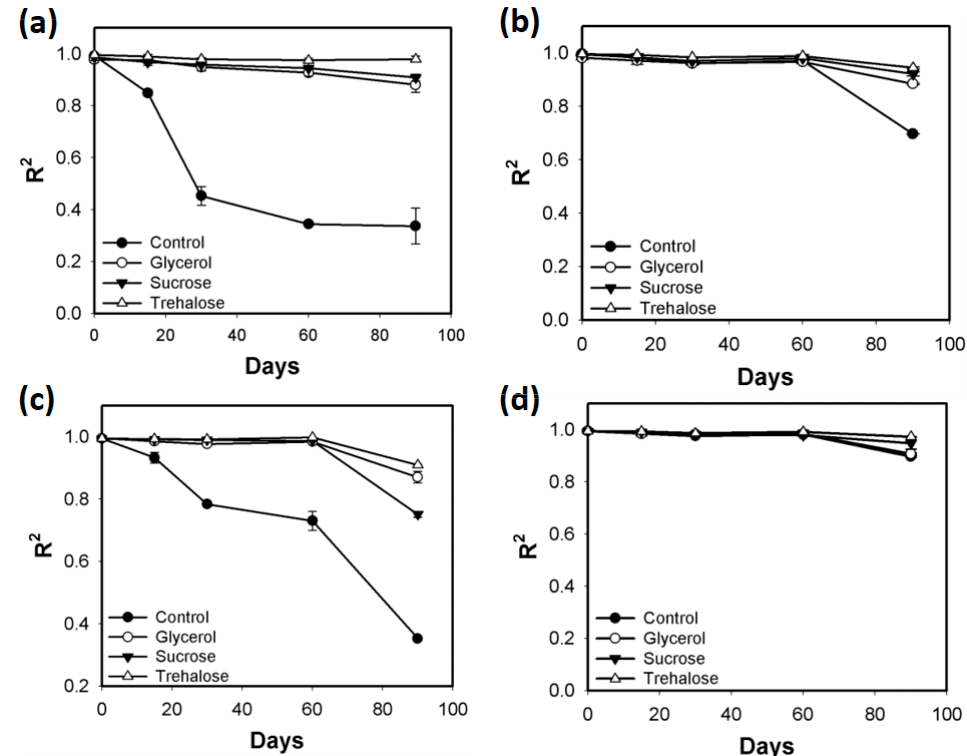
Figure 3. Coefficient of determination (R 2 ) values of the Met calibration curves generated using the amino acid array containing carbohydrate-type cryoprotectants (5%) during the long-term storage period (3 months) under the following conditions: ( a ) agarose immobilization at − 20 °C, ( b ) agarose immobilization at − 80 °C, ( c ) without agarose immobilization at − 20 °C, and ( d ) without agarose immobilization at − 80 °C. Error bars represent standard errors derived from three independent measurements.